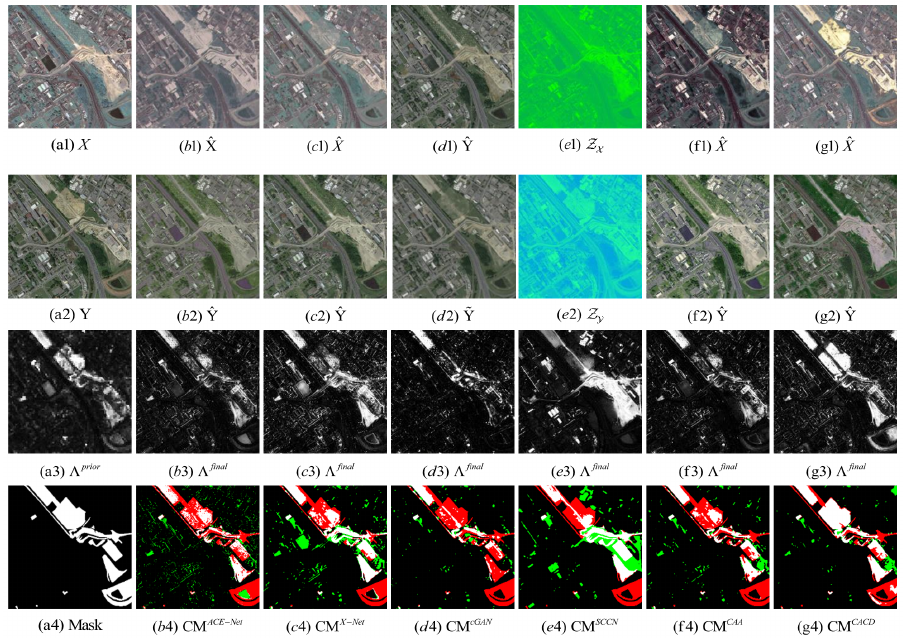
Figure 12. Toulouse dataset. ( a1 ) Input image X . ( a2 ) Input image Y . ( a3 ) Prior difference matrix generated by IRG-McS. ( a4 ) Real mask. ( b – g ) represent the results of ACE-Net, X-Net, cGAN, SCCN, CAA and CACD (US) methods, respectively. ( b1 , c1 , f1 , g1 ) transformed image ˆ X . ( d1 )